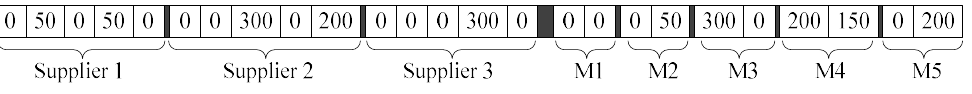
Figure 6. The first and second sections of chromosome in stage 2.